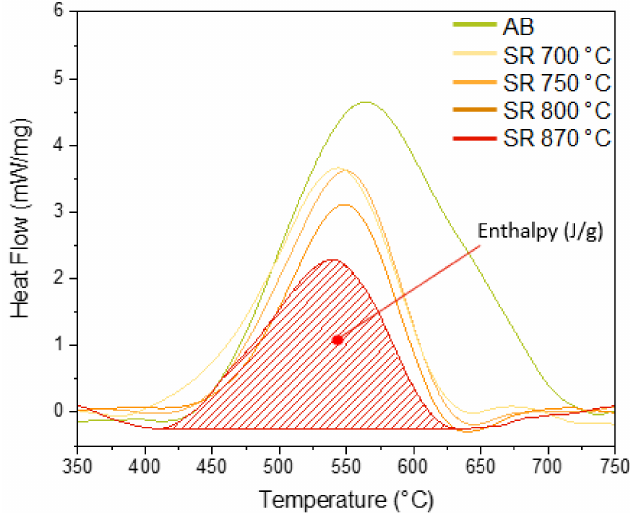
Figure 7. DSC signals of as-built and stress-relieved samples of